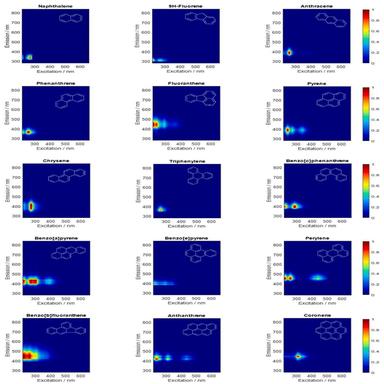
Reference EEMs of selected PAHs at 1750 K.